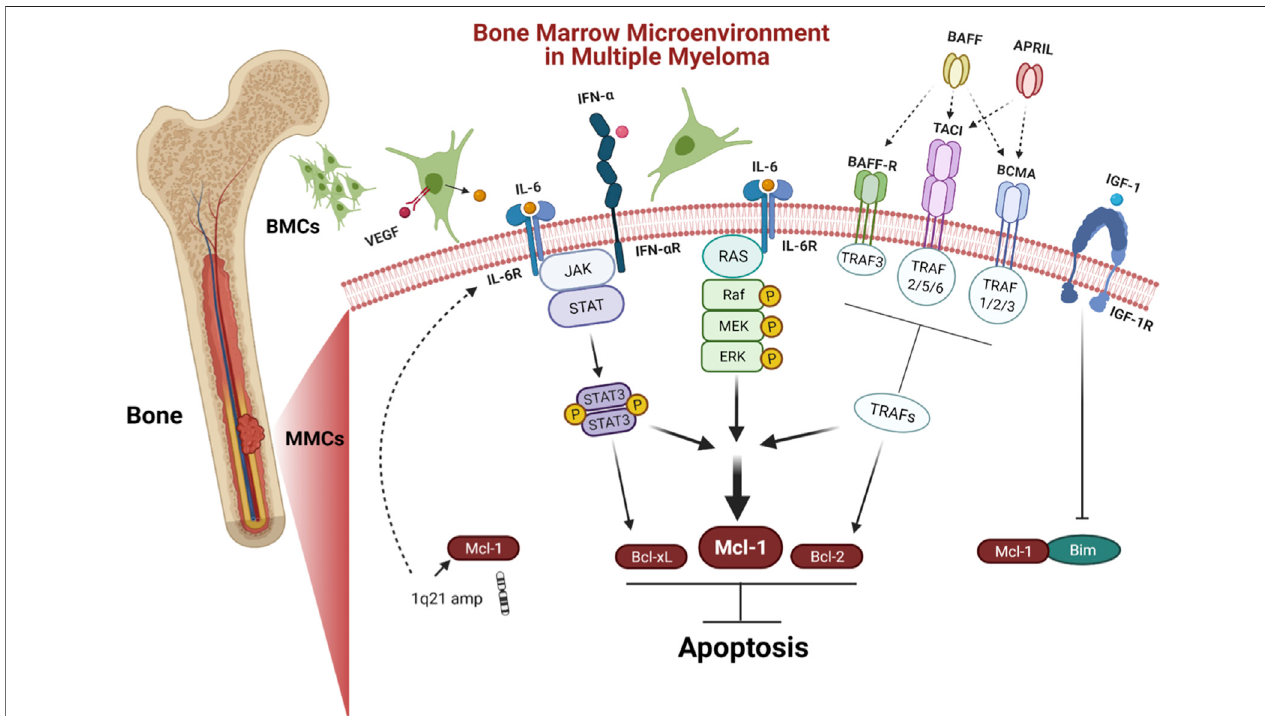
FIGURE 3 | Bone marrow microenvironment (BMM) in MM. BMM facilitates the long term survival of MM. Stromal cells in BM regulate anti-apoptotic proteins by secreting a variety of signaling molecules including IL-6 and IFN- α that trigger JAK/STAT pathway, leading to the upregulation of Mcl-1, Bcl-xL, and VEGF. VEGF promotes IL-6 induction in neighboring BMCs. Furthermore, IL-6 induces survival of MM cells via Ras/MAPK pathway, which modulates the expression of Mcl-1 The tumor necrosis factor (TNF) family including BAFF and APRIL are other stimuli from the BMM that induce expression of both Mcl-1 and Bcl-2 via tumor necrosis factorreceptor-associatedfactors(TRAFs)includingBAFF-R,BCMA,andTACI.IGF-1isanotherstimulusthatactsbydownregulatingBim,leadingtoreleaseMcl-1.MM cases have shown chromosomal ampli fi cation of 1q21 region, where the gene coding for Mcl-1 and IL-6R are